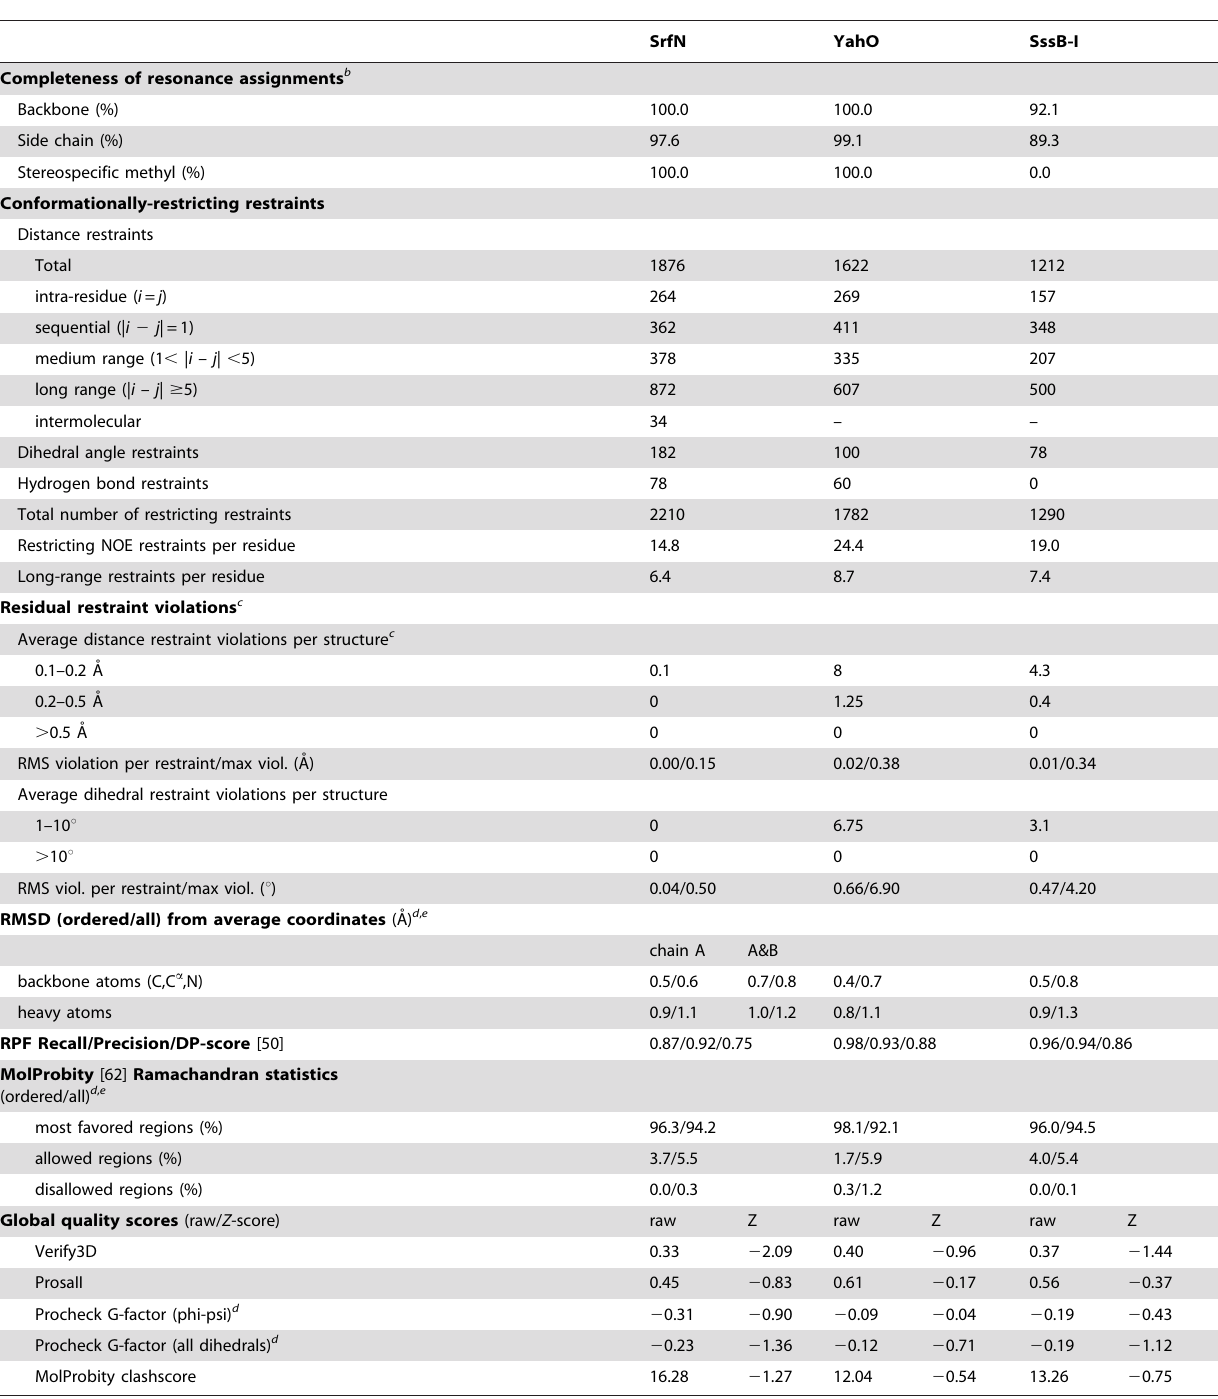
Table 1. Summary of NMR and structural statistics a for Salmonella SrfN, YahO, and